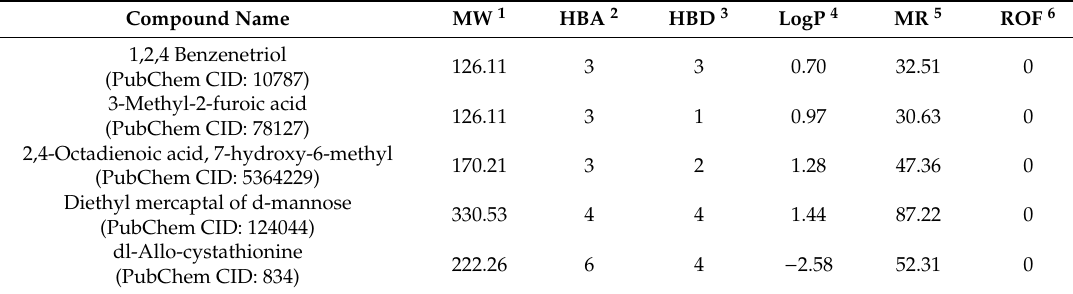
Table 4. ADME / T properties of MECVL by